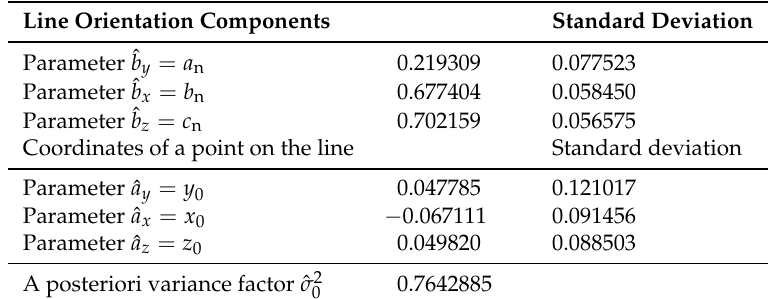
Table 1. Least squares solution within the Gauss–Helmert (GH) model of Snow and Schaffrin [6].